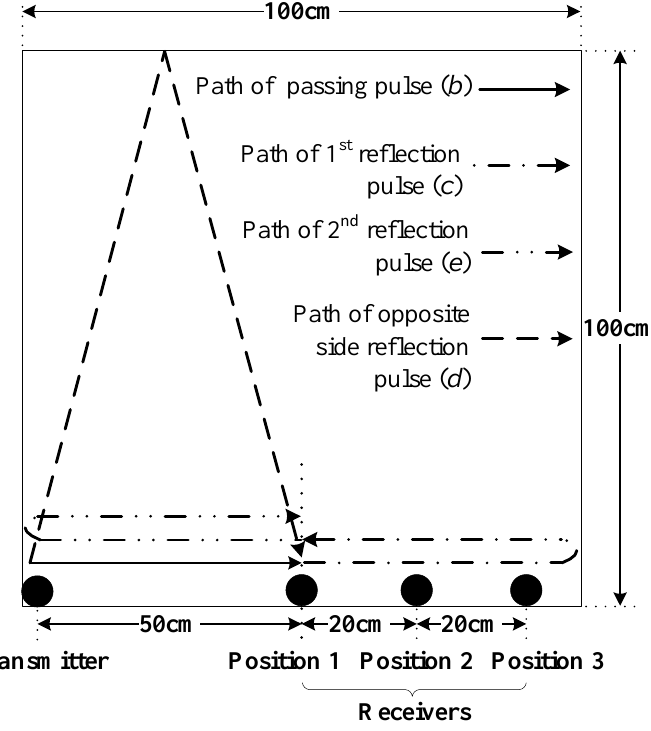
Figure 5. Schematic diagram of the EMAT positions and the propagation paths of the ULW